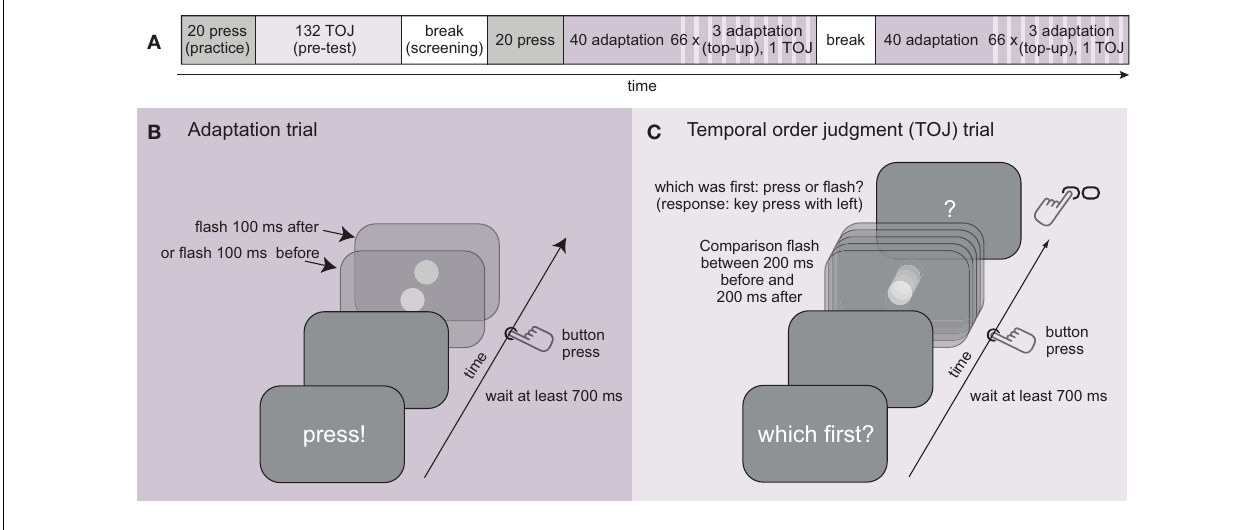
judgment (TOJ) trials, participants respond with a key press of their left hand which one they perceived to occur first – button press or flashed